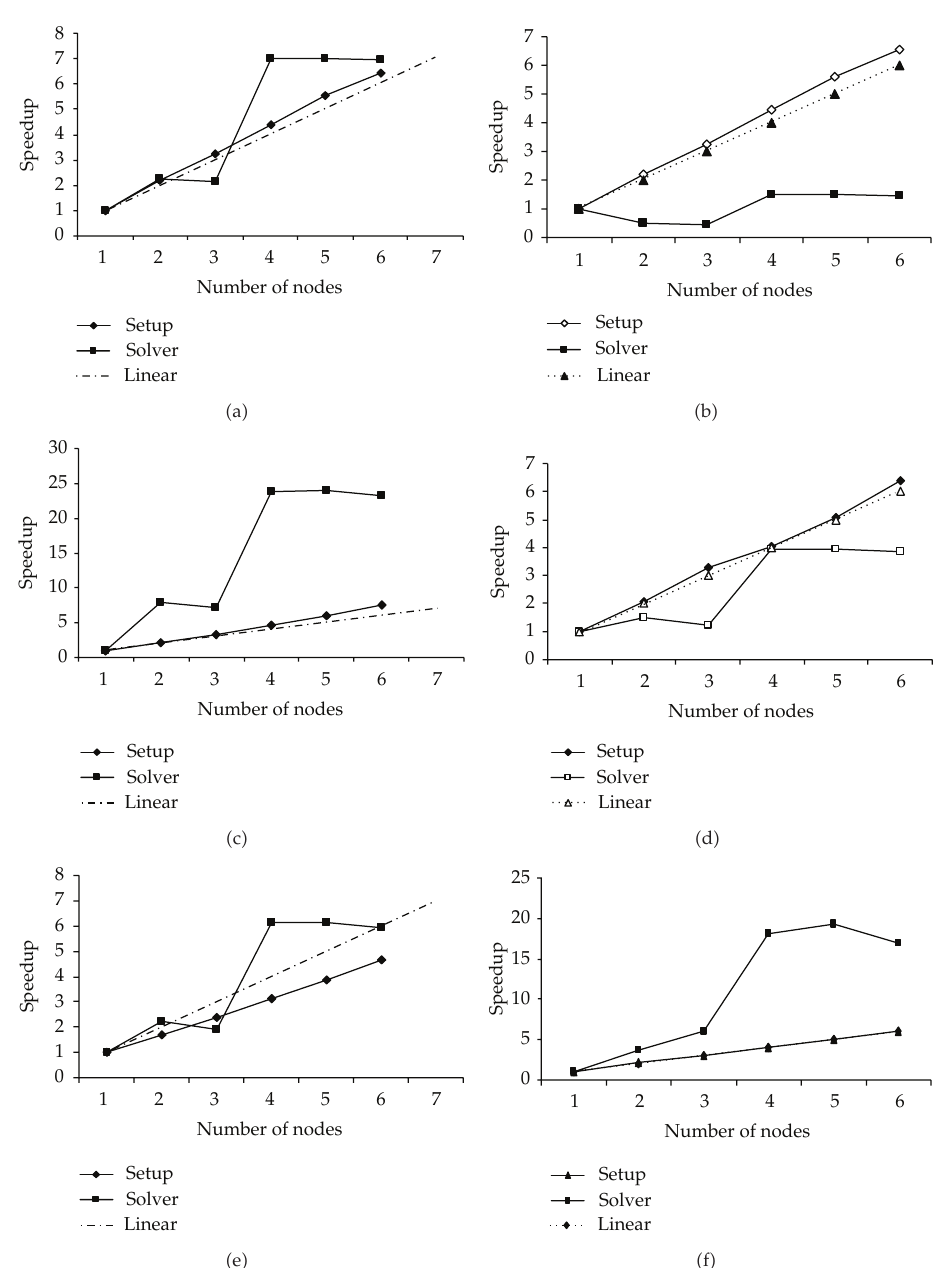
Figure 6: Speedup for 2cubes sphere solver (cid:2) a (cid:3) and preconditioner (cid:2) b (cid:3) , o ff shore solver (cid:2) c (cid:3) and preconditioner (cid:2) d (cid:3) , and circuit5M dc solver (cid:2) e (cid:3) and preconditioner (cid:2) f (cid:3)